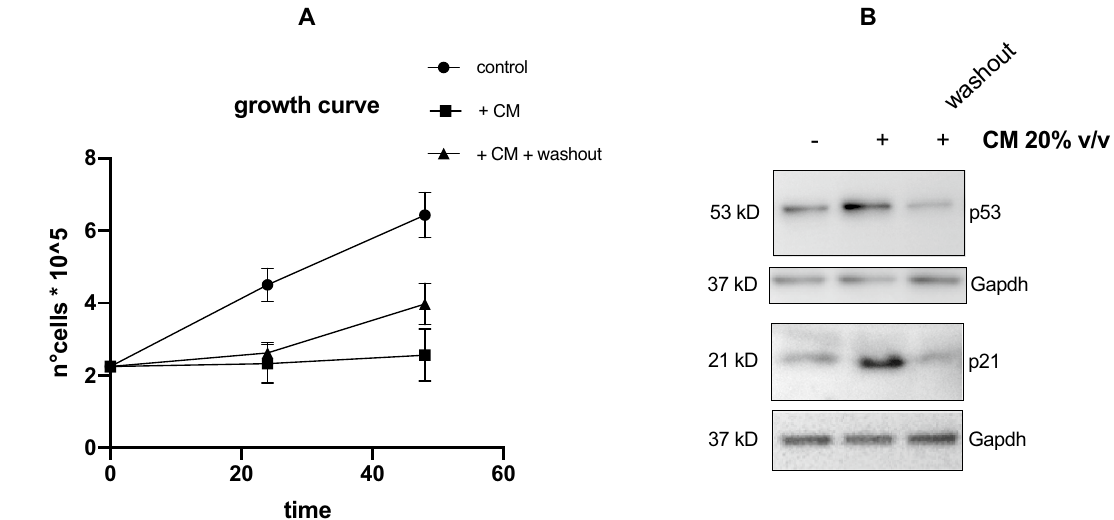
Figure 4. The conditioned Medium of L. gasseri SF1183 affects HCT116 proliferation in a reversible manner. ( A ) Growth curve of HCT116 cells either grown in complete medium (control, circles) or in medium supplemented with CM (squares). Cells were also grown for 16 h in presence of CM; after that, cells were washed out from CM and let grow till 24 h and 48 h total (curve with triangles). Statistical analyses were performed using 2-way ANOVA and Turkey’s multiple comparison test. Levels of significance (**** p < 0.0001). ( B ) At 24 h of growth an aliquot of cells was collected and whole protein extracts were analyzed by western blot with antibodies against p53, p21 and Gapdh. Band intensities were normalized on Gapdh of each blot and expressed as ratio respect to